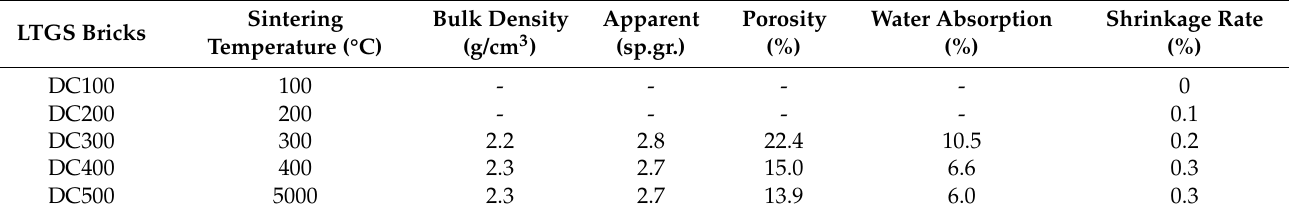
Table 4. Effect of temperature on the physical properties of LTGS bricks.